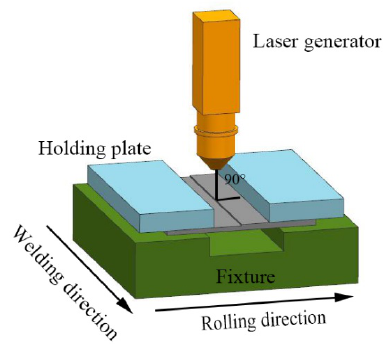
Figure 2. Schematic illustration of the welding process.